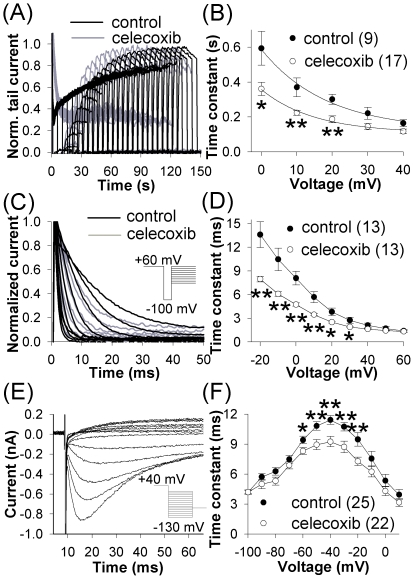
Celecoxib accelerated kinetics of activation, inactivation and re-activation of the hERG channels.(A) Examples of currents recorded during envelope-of-tails protocol to measure rates of activation at +20 mV in control and at 10 µM celecoxib. The protocol consisted of a variable duration (between 10 and 3,000 ms) pre-pulse to +20 mV followed by a test pulse to −60 mV. (B) Voltage dependence of the τact. (C) Examples of inactivating currents in control and at 10 µM celecoxib. The protocol consisted of a 2 s first pre-pulse to +60 mV, a 10 ms second pre-pulse to −100 mV, and a test pulse between −20 and +60 mV in 10 mV increments. (D) Voltage dependence of the τinact. (E) An example of re-activating current in control evoked by a 2 s pre-pulse to +40 mV followed by a 50 ms test pulse between −130 and +10 mV in 10 mV increments. (F) Voltage dependence of the τreact.